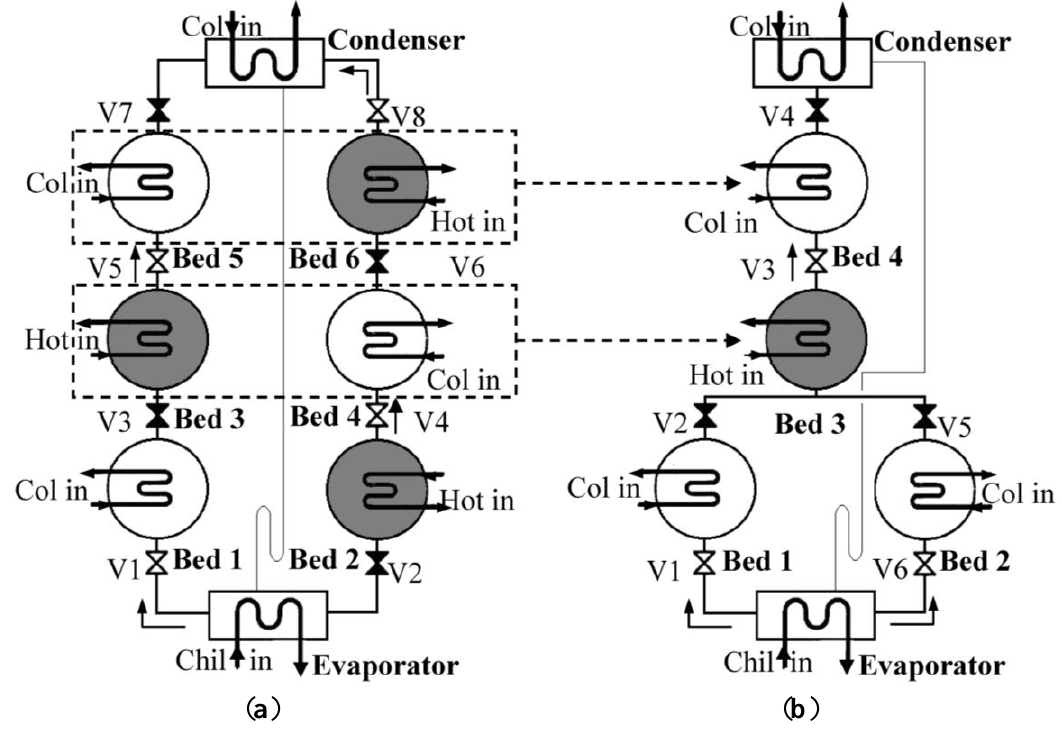
Figure 1. Schemata of ( a ) six-bed, three-stage chiller of Saha et al. [1] and ( b ) proposed design of four-bed, three-stage adsorption cycle with operation mode A (see Table 1b).